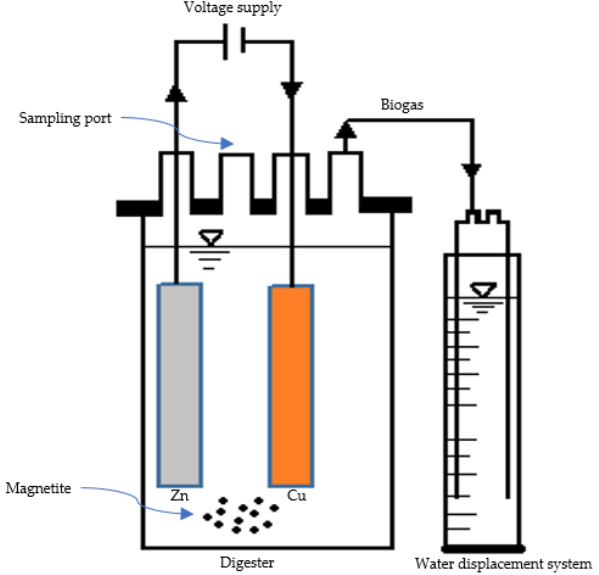
Figure 8. Equipment setup for the MEC